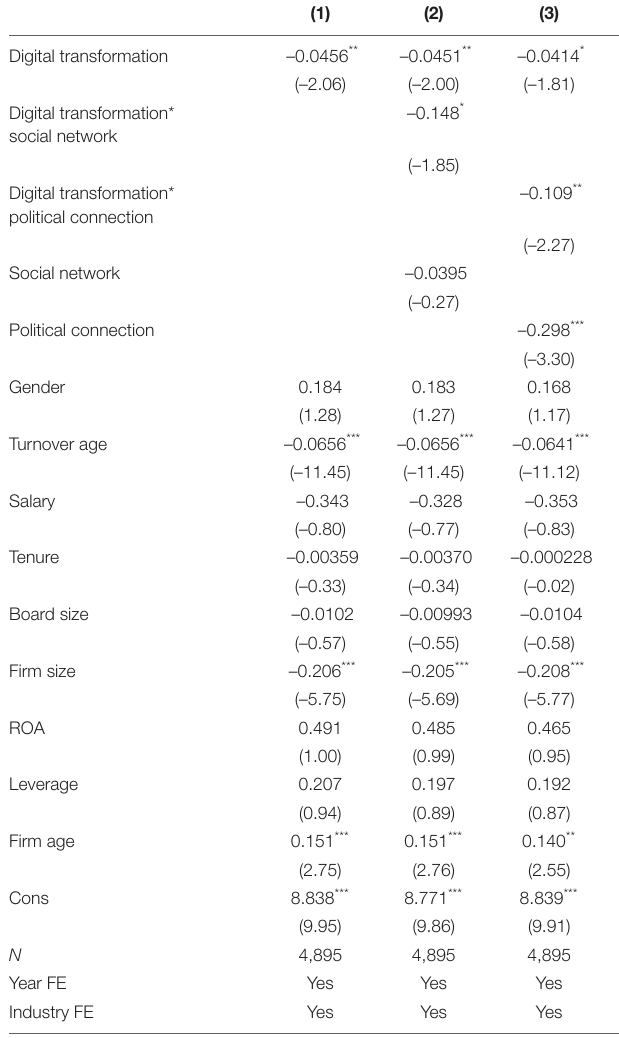
TABLE 3 | The result of binary logistic